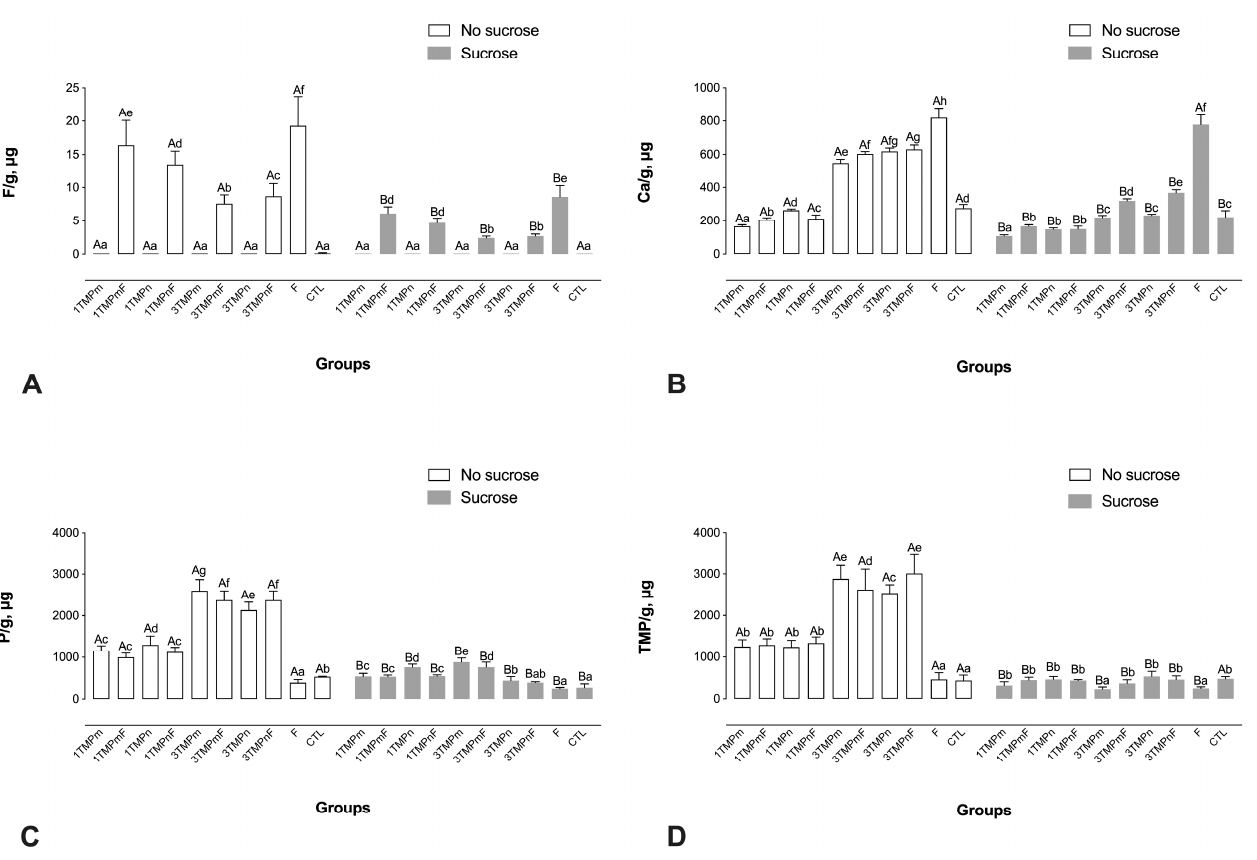
Figure 3. Mean values of F ( A ), Ca ( B ), P ( C ), and HMP ( D ) in the biofilm biomass, prior to and after exposure to sucrose (cariogenic challenge). Distinct upper ‐ case letters indicate statistical differences within each group regarding exposure to a 20% sucrose solution (in two levels – yes or no). Distinct lower ‐ case letters indicate statistical differences among the experimental groups (all test solutions) within each condition of sucrose exposure). Data were submitted to 2 ‐ way ANOVA, followed by Fisher LSD ʹ s post hoc test for multiple comparisons ( p < 0.05). Bars denote standard deviations of the means. The experiments were performed in triplicate, in three different moments ( n = 9). Ca: calcium; F: fluoride; P: phosphorus; TMPm: micro ‐ sized sodium trimetaphosphate; TMPn: nano ‐ sized sodium trimetaphosphate; CTL: negative control.